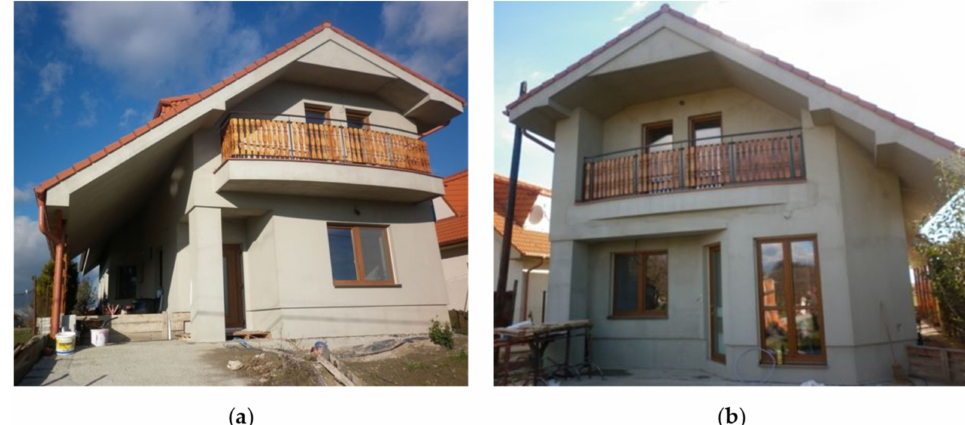
Figure 26. Experimental house EB2020: ( a ) View from the street; ( b ) view from the garden. [Author: Kal ú